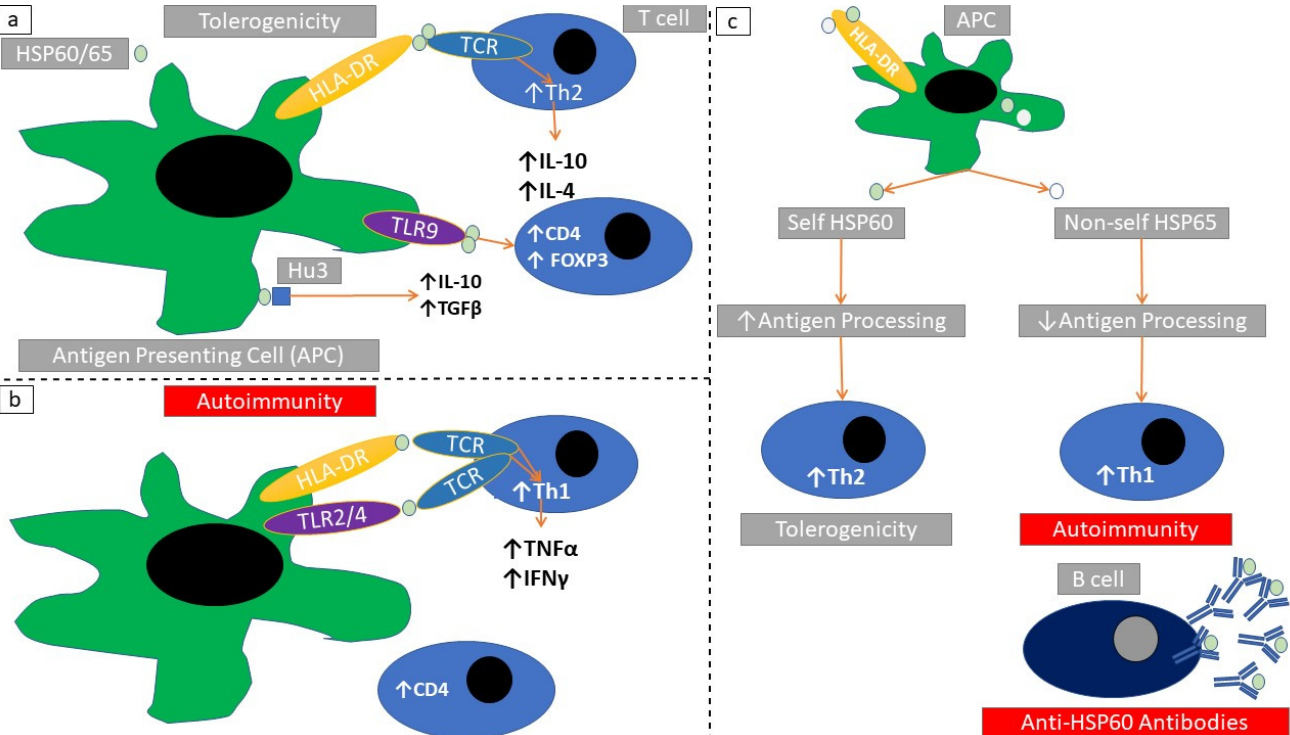
Figure 6. Immunomodulatory actions of HSP60/65. ( a ) HSP60/65 induce a Th2 cytokine response after stimulating TLR9/HLA-DR in antigen-presenting cells. ( b ) HSP60/65 induce a Th1 cytokine response after stimulating TLR2/HLA-DR in antigen-presenting cells. ( c ) Self HSP60 undergoes a complete antigen processing within antigen-presenting cells. This induces Th2 responses and tolerogenicity. Non-mammalian HSP65 undergoes an incomplete antigen processing within antigen-presenting cells. This induces Th1 responses and autoimmunity. Non-self and self HSPs share a conserved amino acid sequence homology. Self-HSP60 can stochastically activate Th1-cell clones. This induces autoimmunity after stimulation with non-self HSP65 molecules. In the case of autoimmunity there can be a parallel production of anti-HSP60/65 autoantibodies.